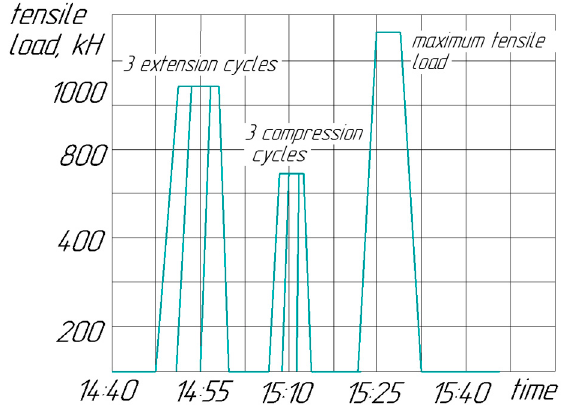
Figure 5. Weight on bit application graph.